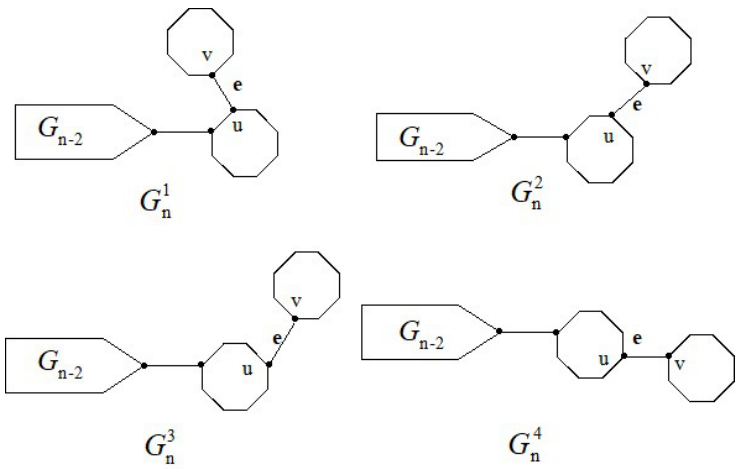
Figure 2. The four types of local arrangements in cyclooctylene